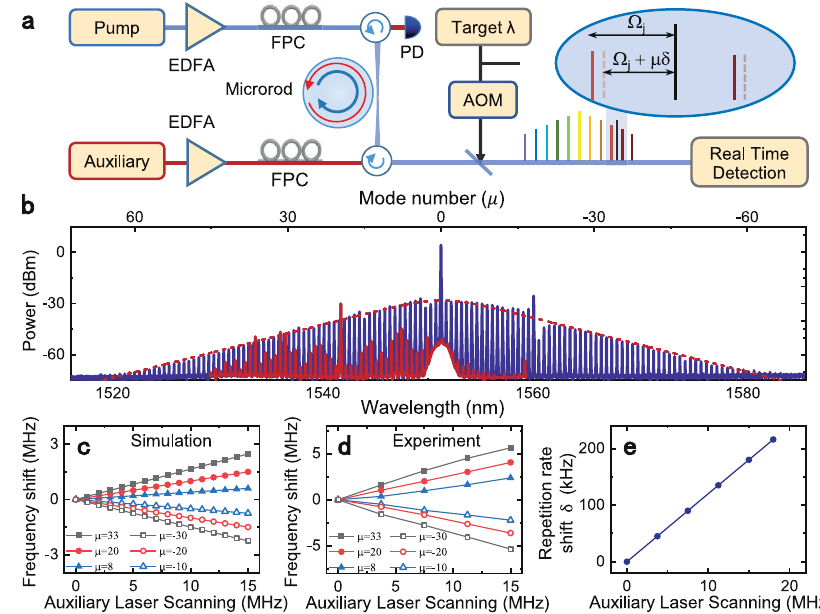
Fig. 2 | Experimental setup, simulation, and veri fi cation measurement. a Experimental setup. AOM: acousto-optic modulator; FPC: fi ber polarization controller; PD: photodetector; EDFA: erbium-doped fi ber ampli fi er. Supplement includes more detail. Inset: The operating principle of the wavemeter. b Typical optical spectra of the soliton microcomb. The blue lines represent the comb lines generated by the pump laser and the red lines are due to backscattering of the